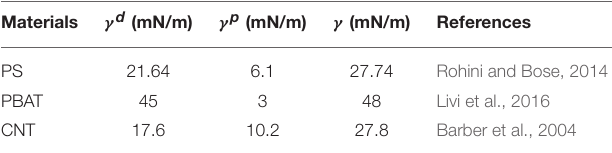
TABLE 3 | Surface energies of the blend component.